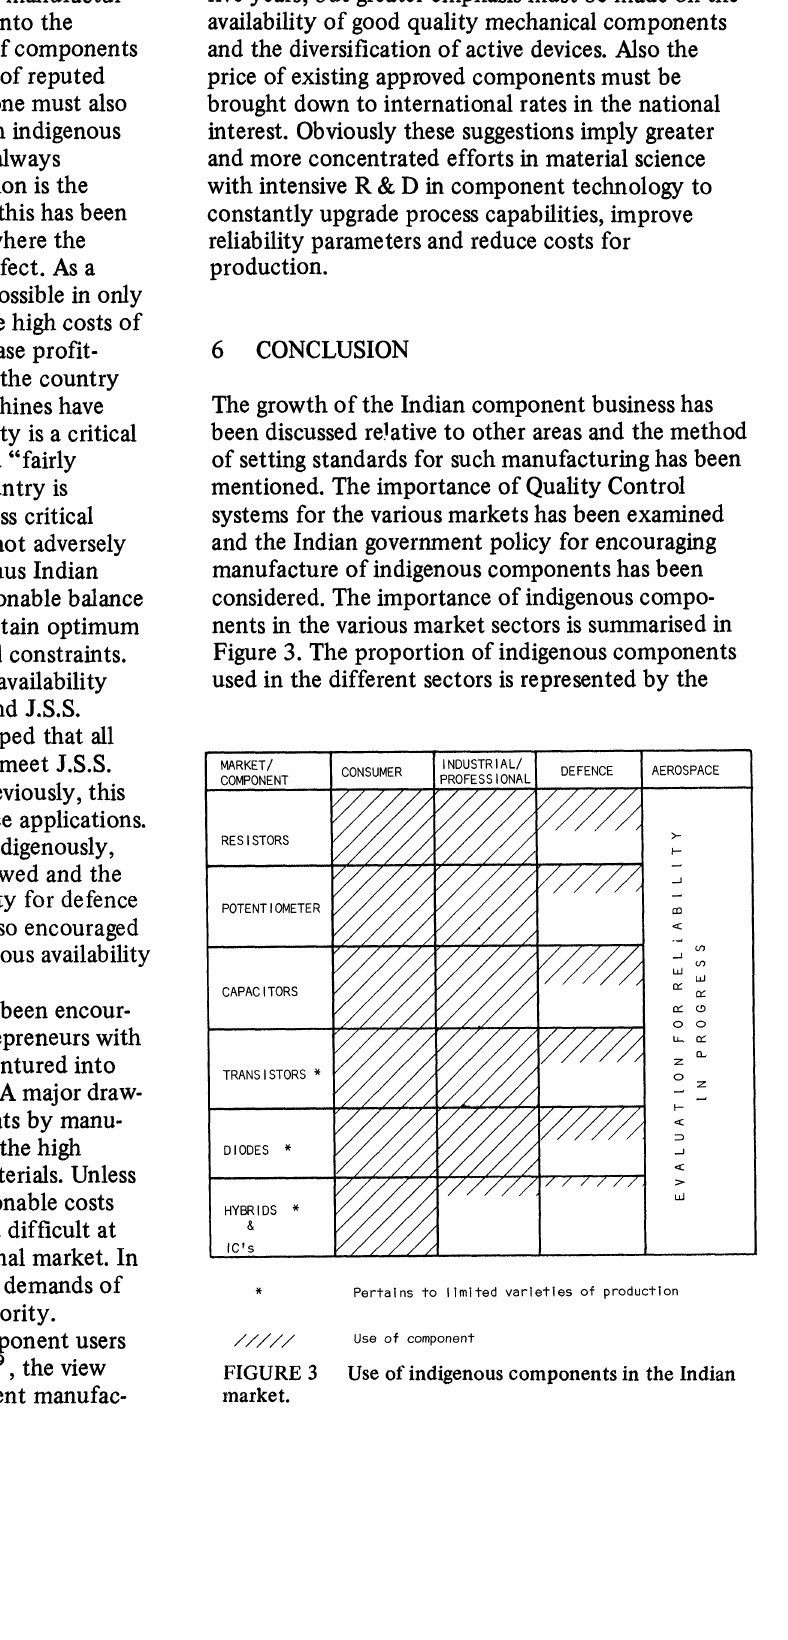
FIGURE 3 market.